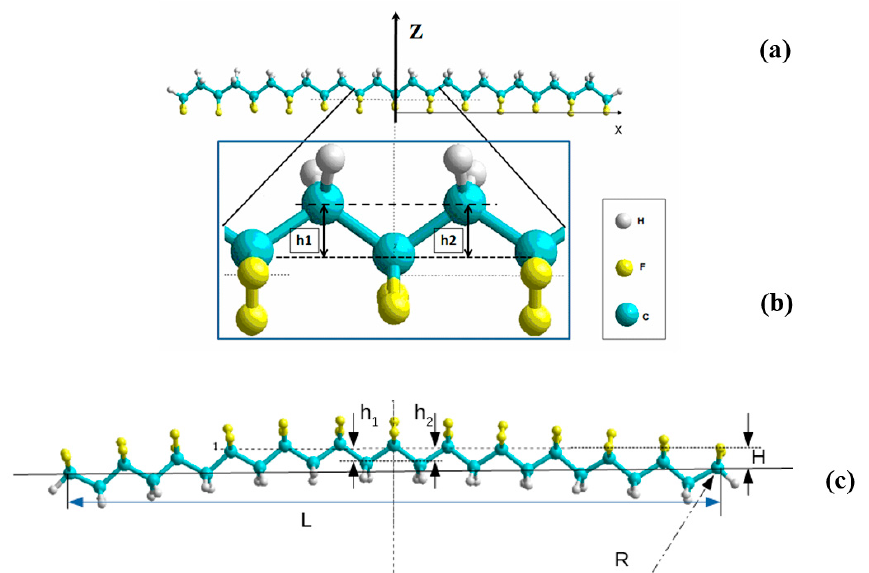
Figure 10. Model of PVDF chain: ( a ) PVDF and ( b ) Its central part, ( c ) Model of curved PVDF chain ( R —radius of curvature, L —chord of curvature, H —height of curved chain on the length of chord L ; h 1 and h 2 are similar as on above Figure 10 b).